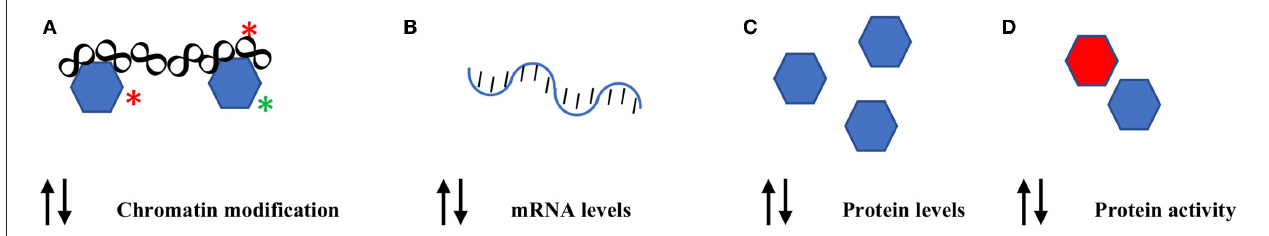
FIGURE 3 | Molecular mechanisms that may contribute to pituitary population restructuring. Pituitary cell populations may utilize multiple molecular mechanisms for restructuring including (A) chromatin remodeling (B) gene transcriptional control (C) control of mRNA translation to protein and (D) control of protein function. The double arrows indicate the potential for both activating (positive) and inhibitory (negative) effects upon these molecular mechanisms. See text for details and relevant